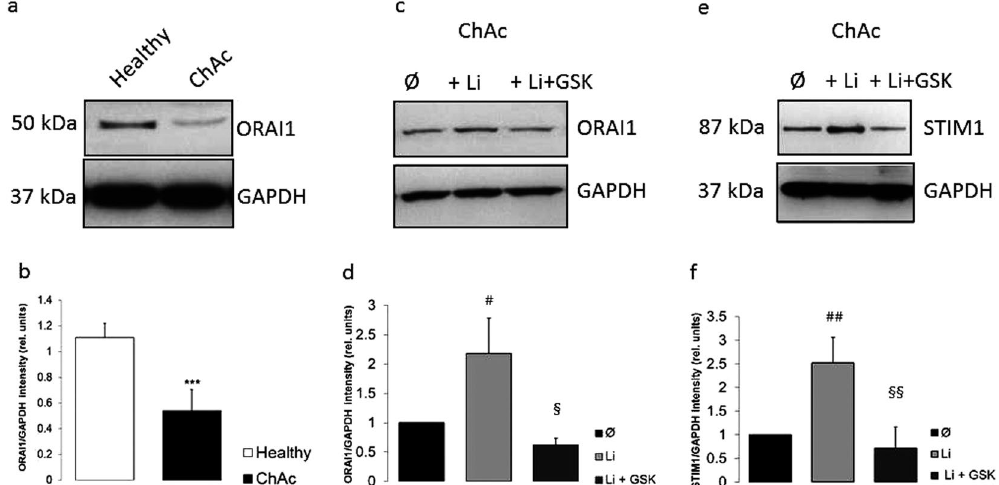
Figure 3. ORAI1 and STIM1 protein abundance in neurons generated from healthy volunteers and from ChAc patients without or with lithium treatment without and with SGK1 inhibitor GSK650394. ( a ) Original Western blot of ORAI1 protein abundance in neurons differentiated from healthy volunteers (healthy) and in neurons from ChAc patients (ChAc). ( b ) Arithmetic means ( ± SEM, n = 4) of ORAI1 protein levels in neurons generated from healthy volunteers (white bar) and in neurons from ChAc patients (black bar). ( c ) Original Western blot of ORAI1 protein abundance in neurons from ChAc patients without (Ø) and with prior lithium (24 h, 2 mM) treatment without ( + Li) and with ( + Li + GSK) additional presence of SGK1 inhibitor GSK650394 (10 µ M). ( d ) Arithmetic means ( ± SEM, n = 4) of ORAI1 protein levels in neurons differentiated from ChAc patients without (black bar) or with lithium (24 h, 2 mM) treatment without (light grey bar) and with (dark grey bar) presence of SGK1 inhibitor GSK650394 (10 µ M). ( e ) Original Western blot of STIM1 protein abundance in neurons from ChAc patients without (Ø) and with prior lithium (24 h, 2 mM) treatment without ( + Li) and with ( + Li + GSK) additional presence of SGK1 inhibitor GSK650394 (10 µ M). ( f ) Arithmetic means ( ± SEM, n = 3) of STIM1 protein abundance in neurons differentiated from ChAc patients without (black bar) or with lithium (24 h, 2 mM) treatment without (light grey bar) and with (dark grey bar) presence of SGK1 inhibitor GSK650394 (10 µ M). *** (p < 0.001) indicates statistically significant difference to respective value in neurons from healthy volunteers, # (p < 0.05), ## (p < 0.01) indicates statistically significant difference to respective value in absence of lithium. § (p < 0.05), §§ (p < 0.01) indicates statistically significant difference to respective value in the absence of